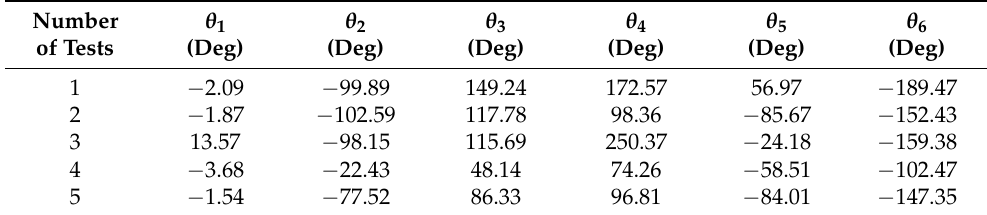
Table 6. Robot configuration for the validation